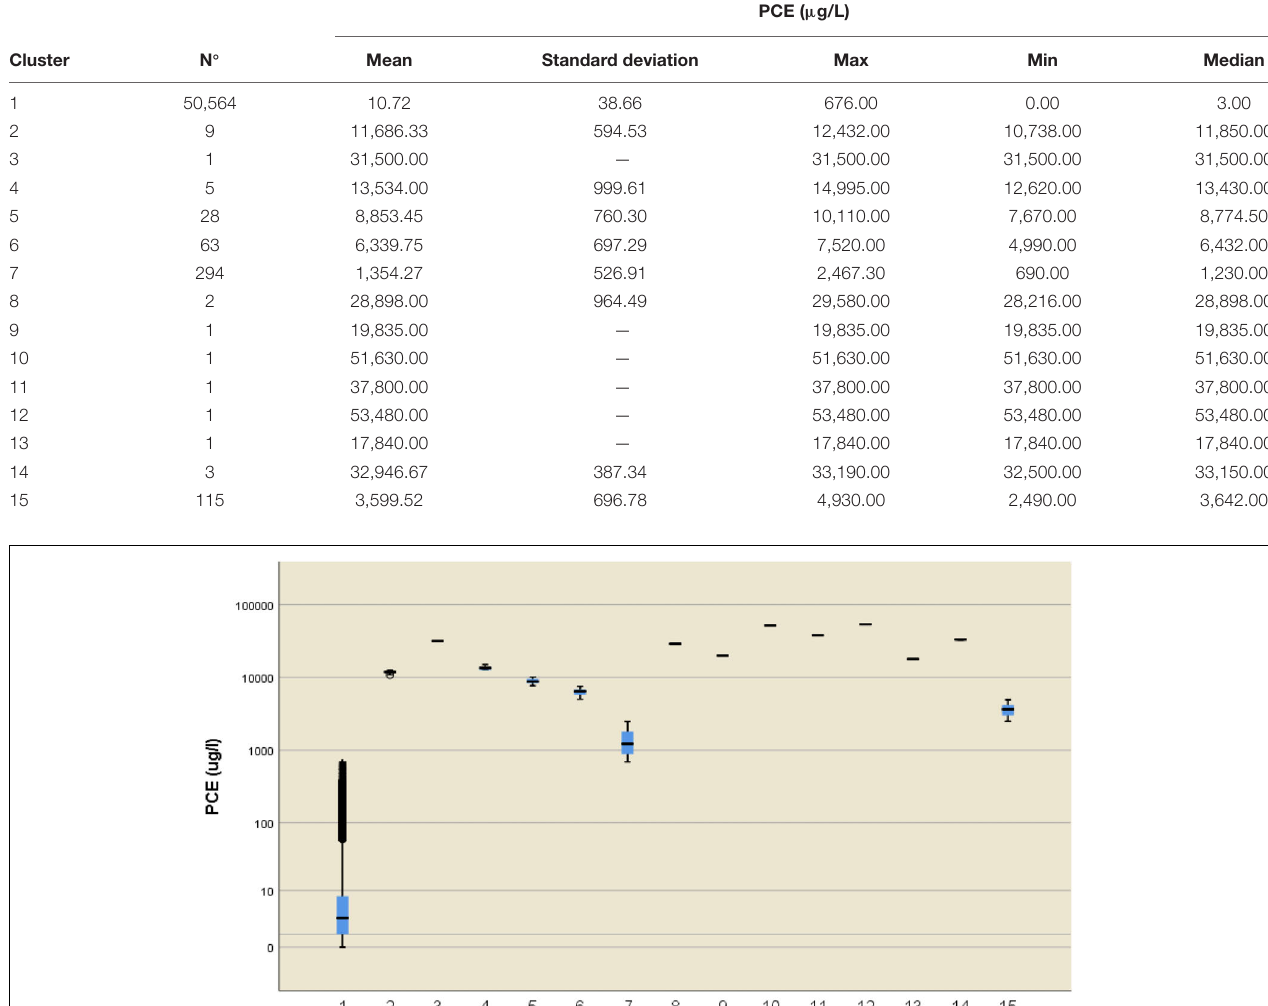
TABLE 2 | The number of cases, frequencies, and summary statistics included in each of the 15 clusters.